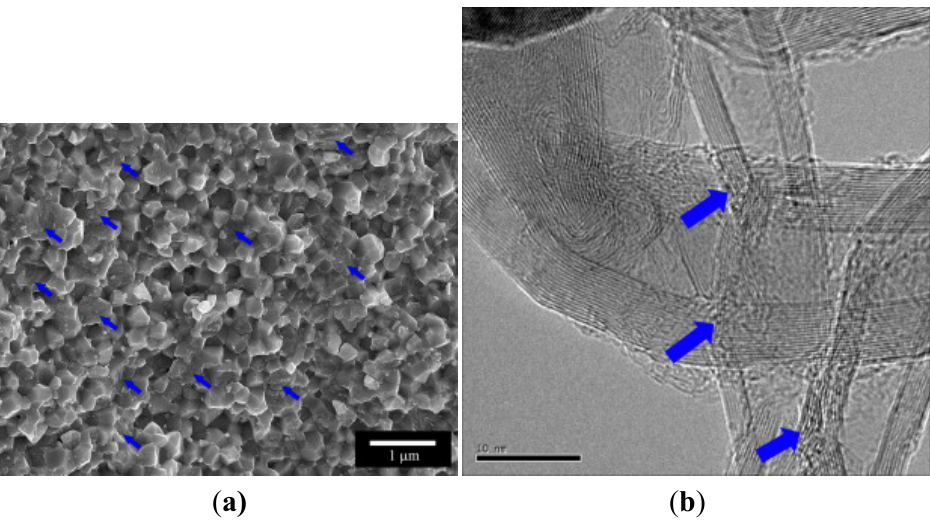
Figure 13. ( a ) SEM micrograph of fracture surface, scale bar: 1 µm; and ( b ) TEM micrograph of sintered sample of CNT reinforced Yttria-stabilized Zirconia (3YZTP) nanocomposite, scale bar: 10 nm. Blue arrows indicate CNTs